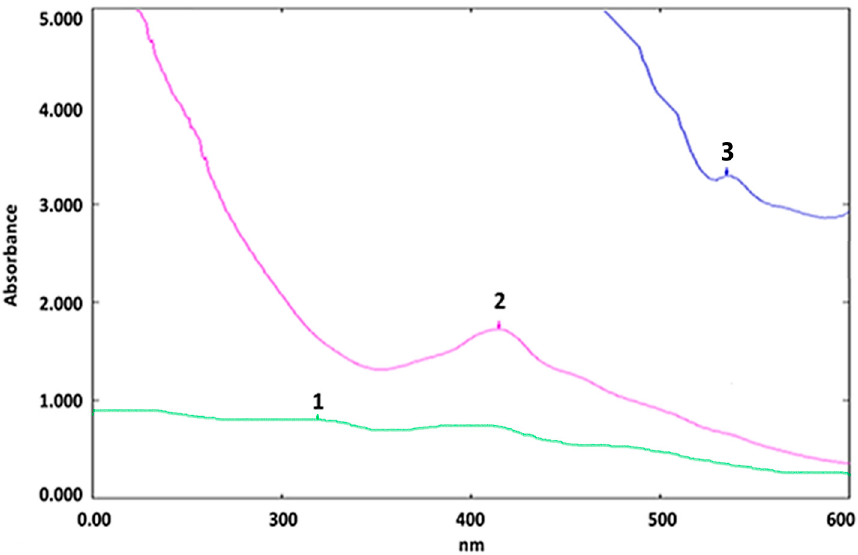
Figure 1. UV–Visible spectrum of silver nitrate solution (curve 1), AgNP (curve 2), and Coccinia indica leaf (CIL) extract (curve 3).